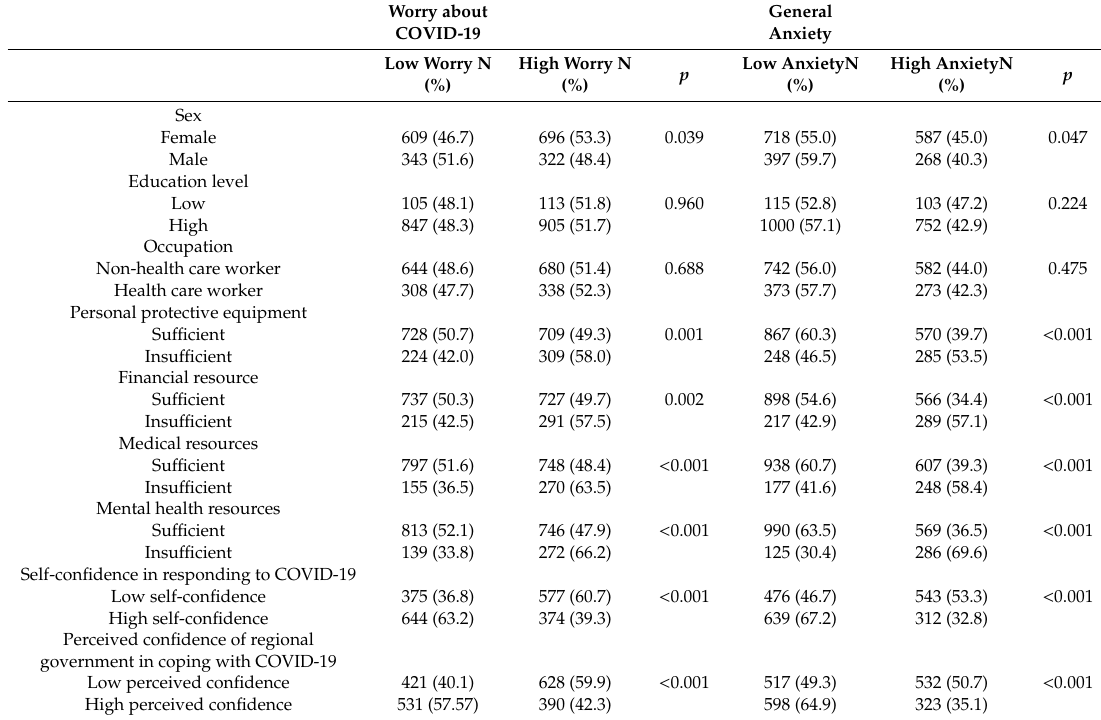
Table 2. Di ff erences in the rates of high worry toward COVID-19 and high general anxiety according to demographic characteristics and resources and support.